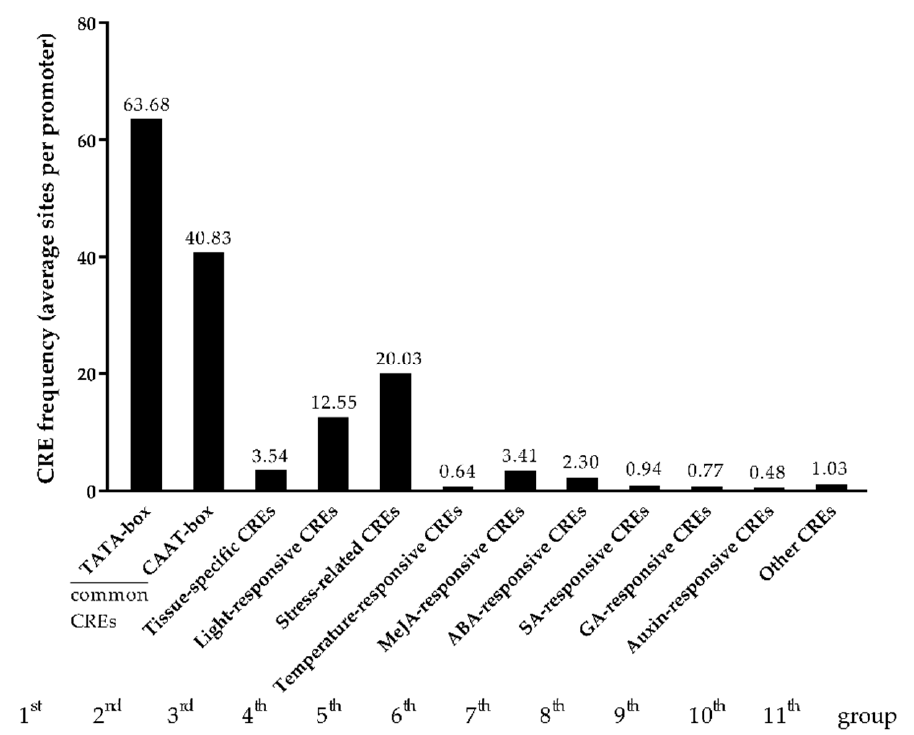
Figure 7. Classification of CREs identified in the promoters of APSGS genes; the x-axis represents the 11 groups of CREs classed by function; the y-axis indicates the CRE frequency: average sites per promoter.